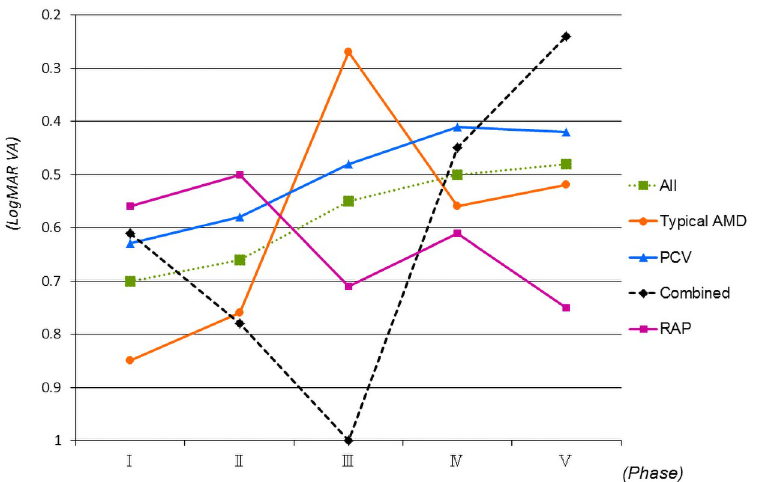
Fig 2. Changes in the mean logarithm of the minimum angle of resolution best-corrected visual acuity (logMAR BCVA) by age-related macular degeneration (AMD) subtypes for the 1,777 eyes. Significantly ( P = 0.0012, P < 0.0001, P < 0.0001, respectively, Mann-Whitney U -test) better baseline VAs are seen in phases III, IV, and V compared with phase I. Phases I, II, III, IV, and V spanned, respectively, March 2003 to February 2005, March 2005 to February 2007, March 2007 to February 2009, March 2009 to February 2011 and March 2011 to February 2013. RAP = retinal angiomatous proliferation; combined = combined subtypes; PCV = polypoidal choroidal vasculopathy. https://doi.org/10.1371/journal.pone.0261320.g002 Lesion size Of the 1,777 study eyes, the mean lesion size measured by FA was 6.2 DA. The mean lesion sizes in typical AMD (757 eyes), PCV (798 eyes), and RAP (124 eyes) were 5.6, 7.0, and 4.8 DA, respectively (Table 1). No significant differences were seen between typical AMD and PCV ( P = 0.11, Mann-Whitney U -test) and RAP and PCV ( P = 0.059, Mann-Whitney U -test). The mean lesion sizes in phases I (344 eyes), II (320 eyes), III (365 eyes), IV (338 eyes), and V (410 eyes) were 8.6, 6.7, 5.3, 5.7, and 5.7 DA, respectively. The sizes were significantly